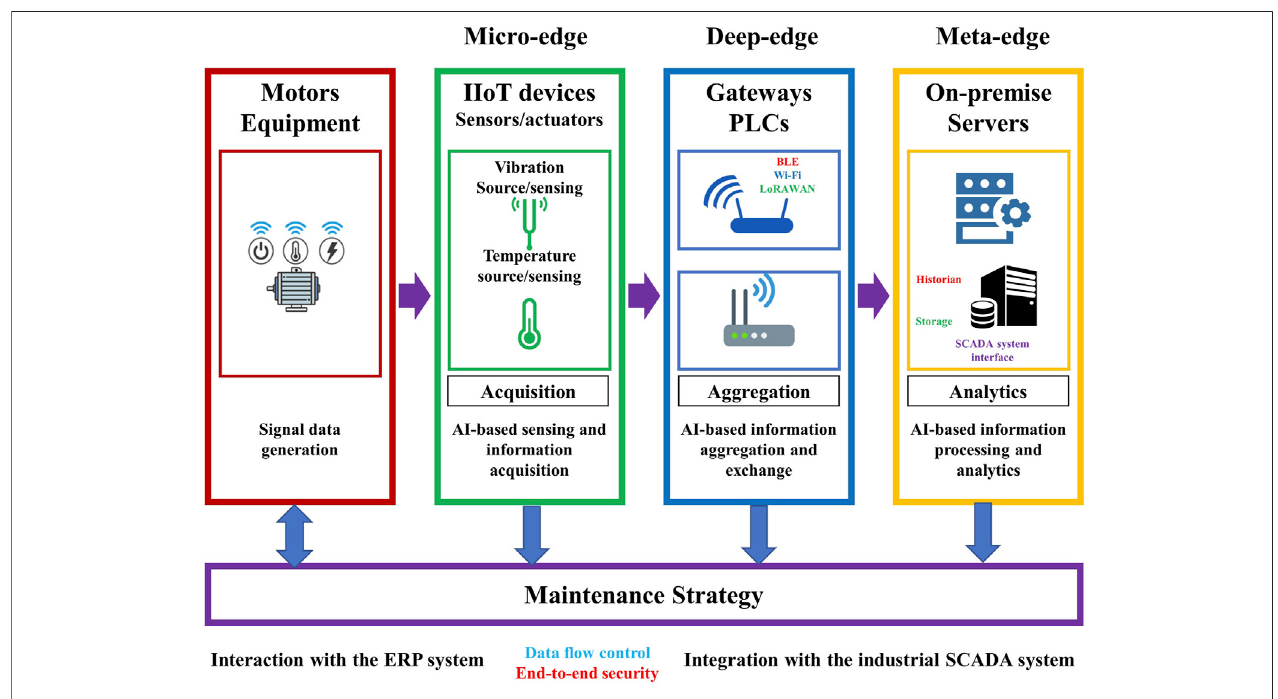
FIGURE 3 | An intelligent real-time edge processing maintenance system for industrial